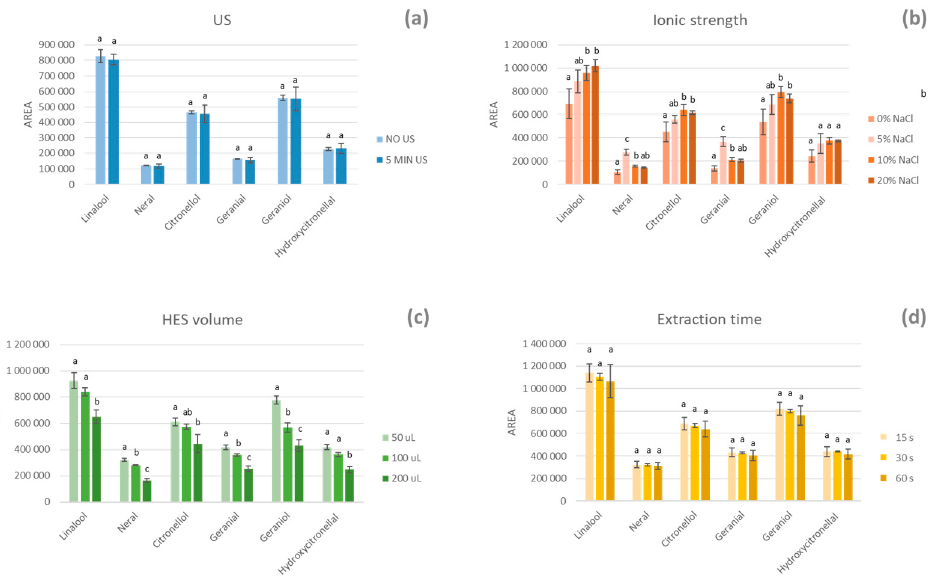
Figure 2. Comparison of the extraction performance (in term of peaks area) of the target analytes obtained by varying the ( a ) ultrasound step, ( b ) ionic strength, ( c ) HES volume, and ( d ) extraction time. Different letters indicate significant differences at p < 0.05 for each compound (Tukey range